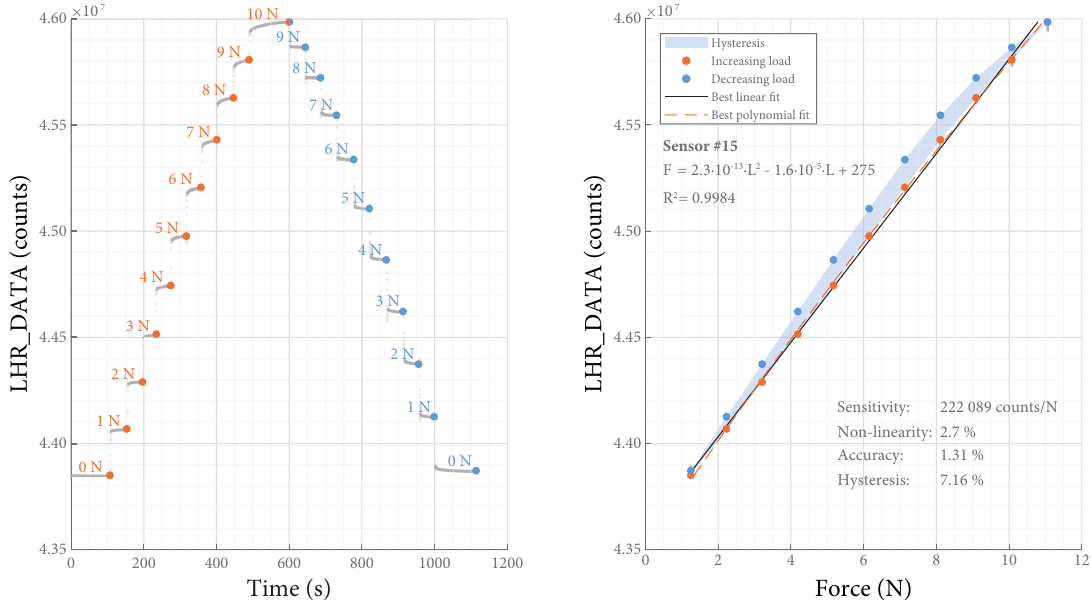
Figure 7. Incremental load test. The results of a typical incremental load